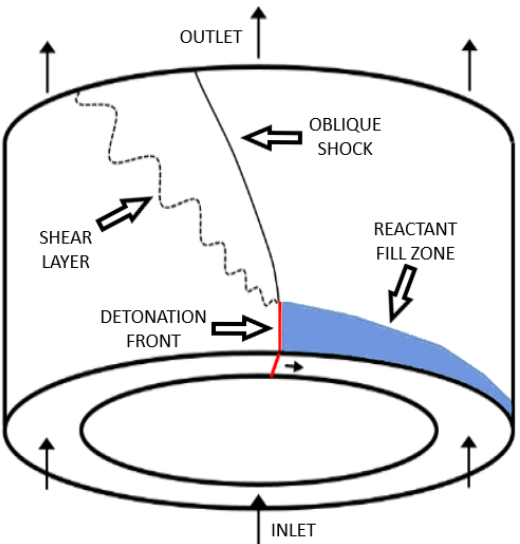
Figure 1. Chamber sketch illustrating common RDRE flow-field